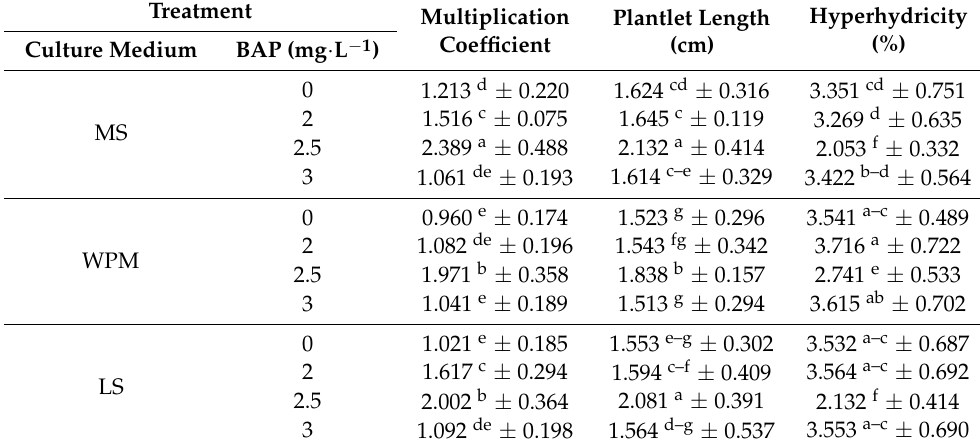
Table 2. Effects of the different concentrations of BAP and the basal culture medium type on the measured characteristics of the Pyracantha angustifolia plants grown in vitro in the multiplication step.